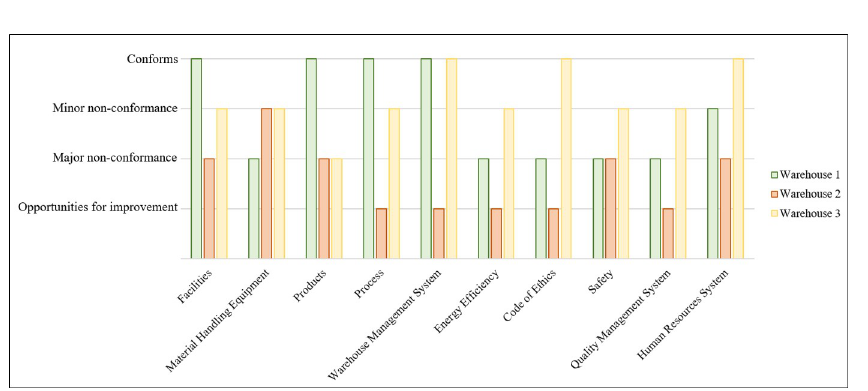
Fig 7. An example of the criteria performance of three warehouses.